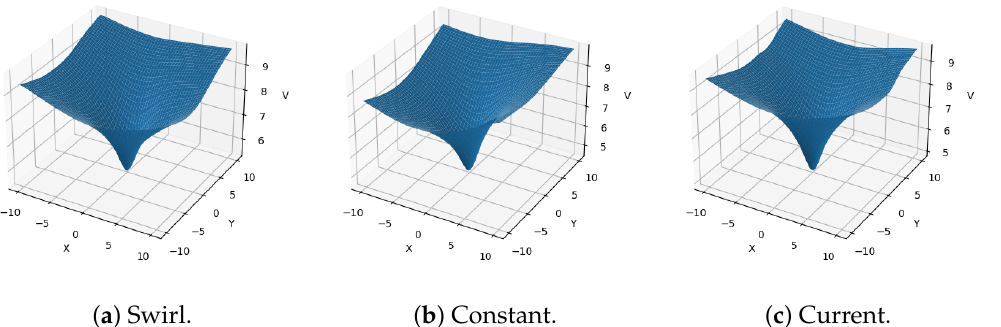
Figure 3. Value function obtained by DGM for each disturbance, where the horizontal axes represent x and y , respectively, and considering that v x = v y = 0. The value plot represent the value function V ( s , t ) that DGM estimates as the solution to the HJB Equation (13) at t = 0; note that each disturbance model yields a different value function, where we can see the shape of the disturbance (compare with the disturbances shown in Figure